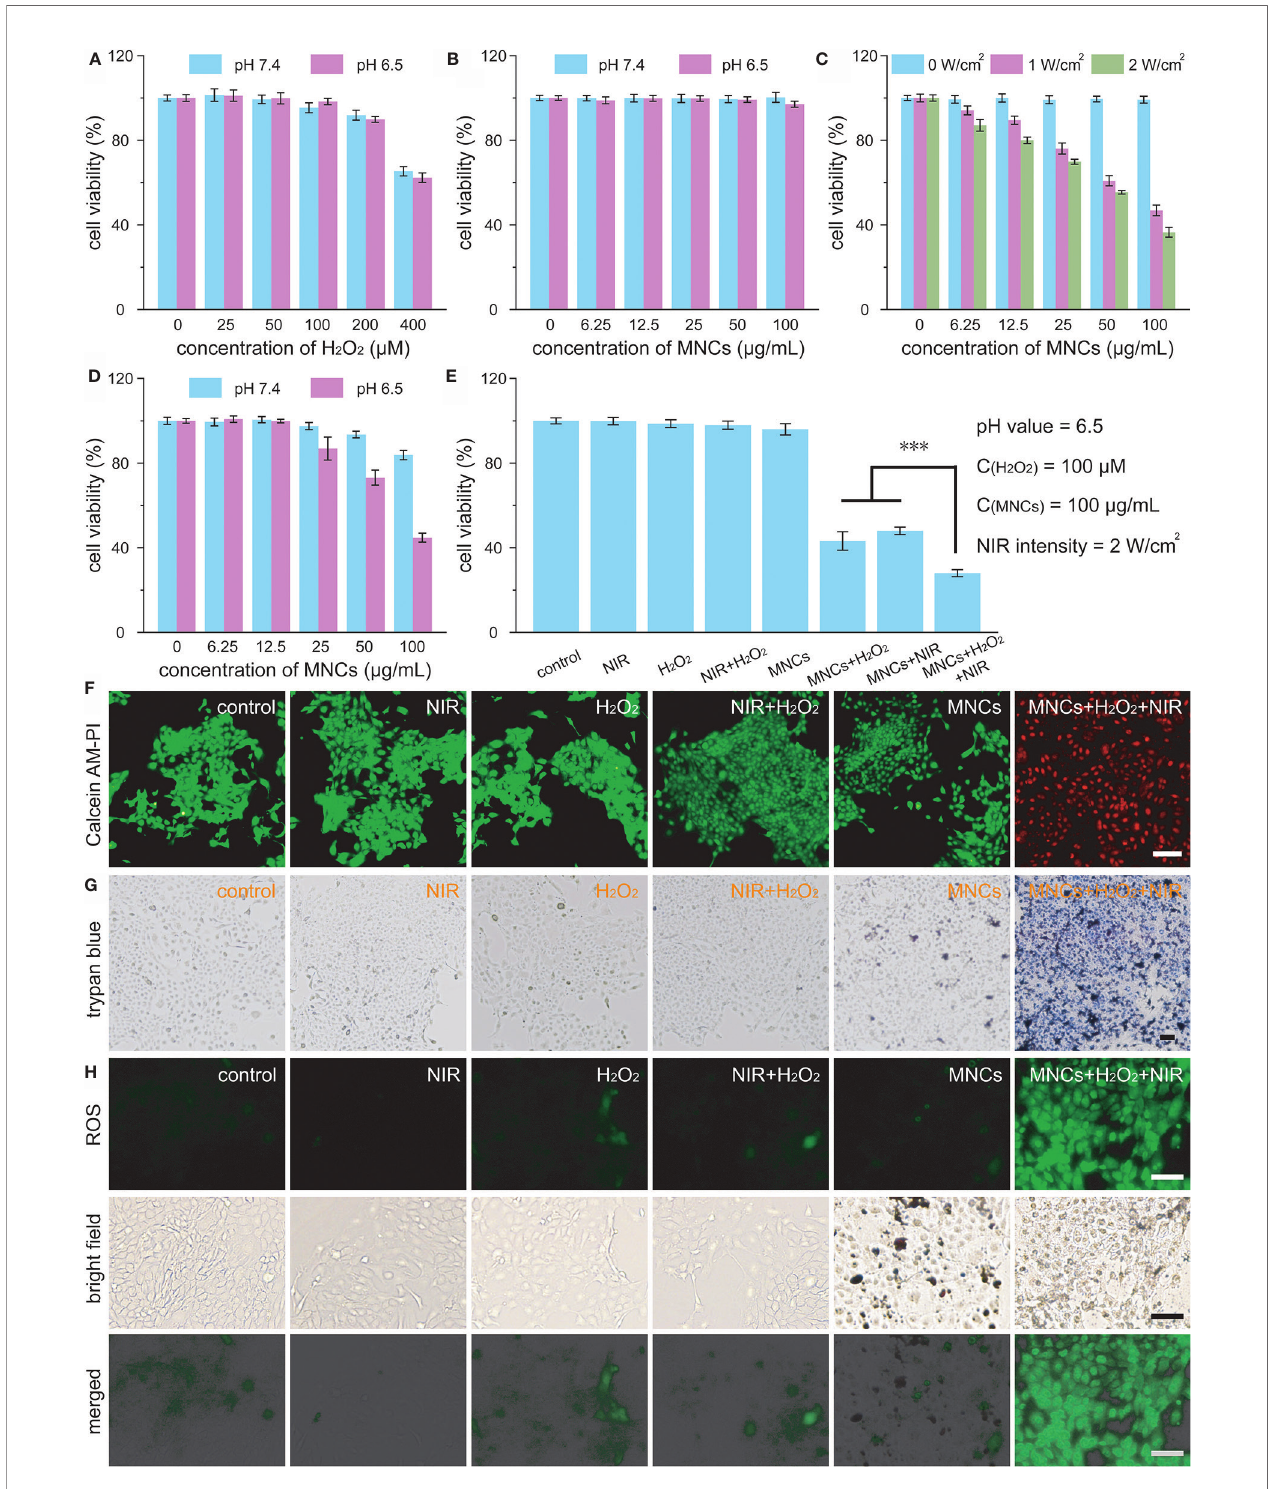
FIGURE 4 | Viabilities of 4T1 cells treated with H 2 O 2 (A) and MNCs (B) under different pH values. Cellular viabilities under laser irradiation in the presence of MNCs (C) . Cellular viabilities under different pH values in the presence H 2 O 2 and MNCs (D) . The concentration of H 2 O 2 in D was 100 m M. Combined in vitro antitumor effect of MNCs with laser irradiation and H 2 O 2 under acidic pH value (E) . Inset of E: detailed experimental conditions. Live-dead staining images (F) , trypan blue staining images (G) , and ROS staining images (H) of 4T1 cells after various treatments. Scale bars are equal to 100 m m. Asterisks indicated statistical signi fi cances (* p < 0.05, ** p < 0.01, *** p <